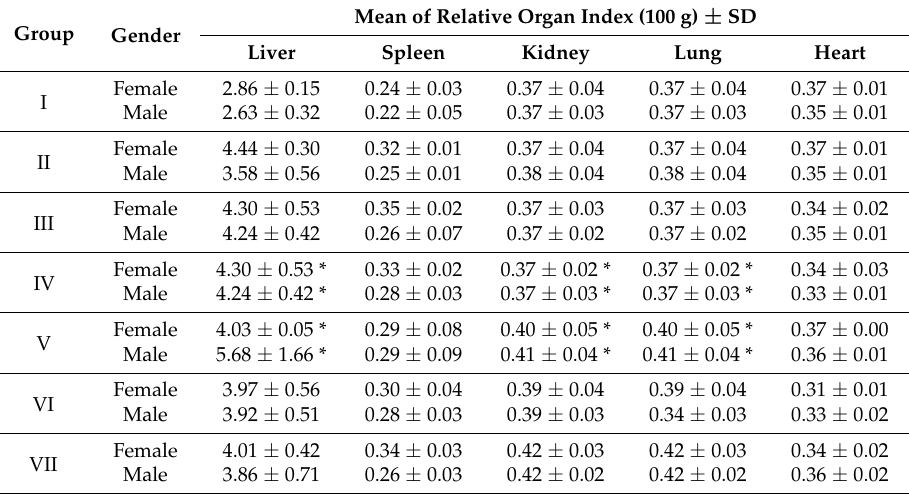
Table 2. Effect of P. fel-terrae leaf extract on relative organ index (Mean ± SD). Group